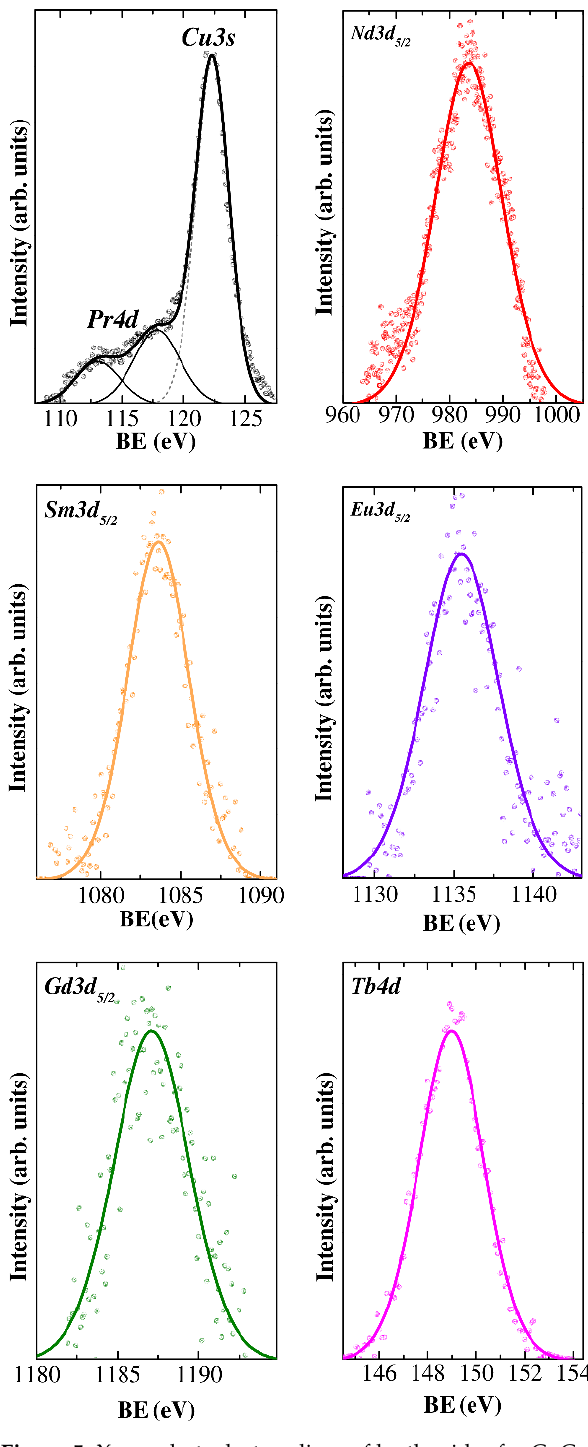
Figure 5. X-ray photoelectron lines of lanthanides for CuCr 0.99 Ln 0.01 S 2 (Ln = Pr – Tb) solid solutions.